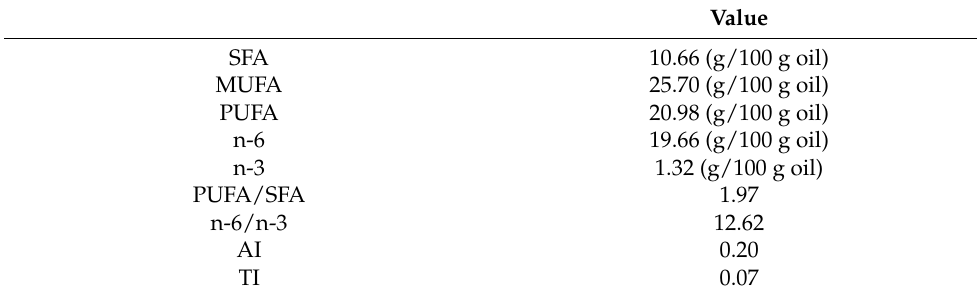
Figure 1. Profile of fatty acids of Mayten tree seed oil. Table 2. Composition of the relevant groups of fatty acids and the nutritional qualities of Mayten tree seed